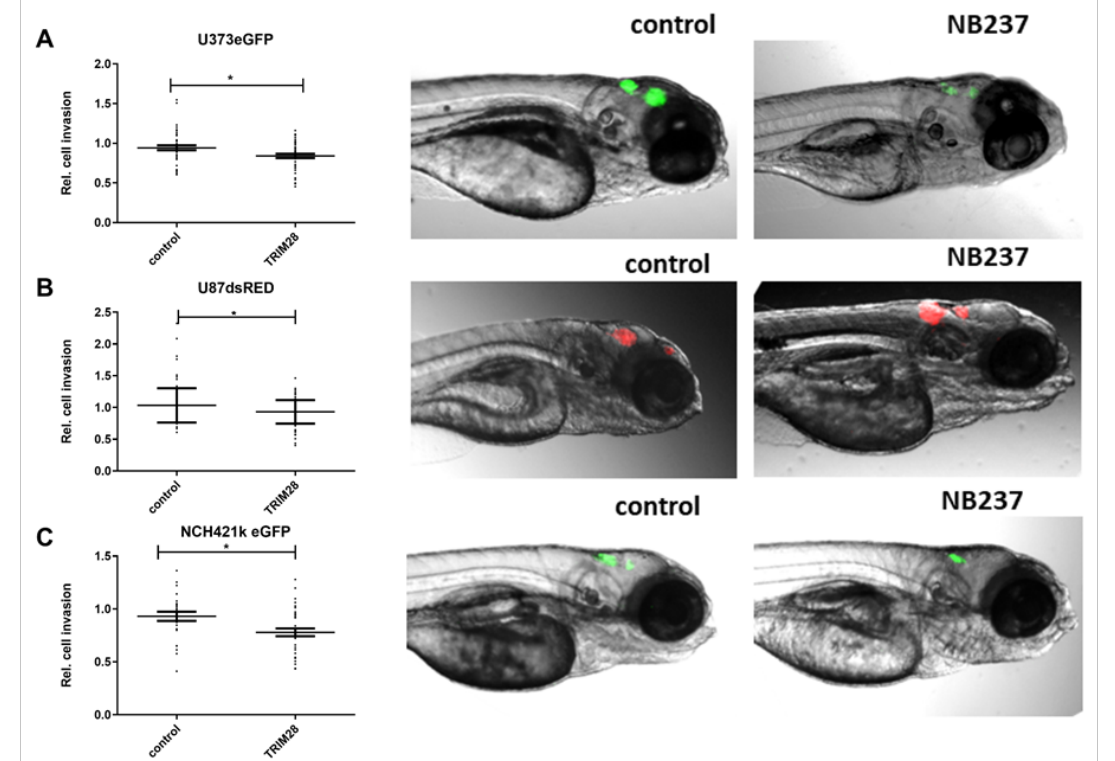
Figure 5. In vivo imaging of GB cell and GSC invasion in the brain of zebrafish embryos. Embryos 72 h after the xenotransplantation of ( A ) U373eGFP, ( B ) U87DsRed and ( C ) NCH421k eGFPcells in the brain (visible as red and green fluorescence) without (control) or with the TRIM28 nanobody NB237. Data are shown as means ± S.D., dots on graphs ( A – C ) represent each embryo. GB xenograft diameter at 72 h was normalized to GB xenograft diameter at 24 h after xenotransplantation to determine the relative cell invasion. Number of embryos in control and with NB237 in the experiment with U373 n = 37–50, U87 n = 94–108, NCH421k n = 13–38. Statistical analyses were performed using GraphPad Prism software, using Mann–Whitney test, * p < 0.05, vs. control group.